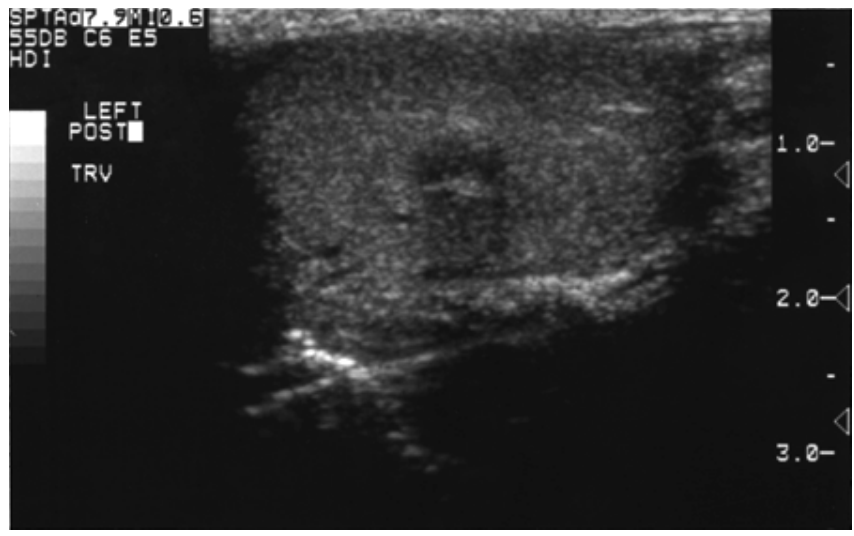
FIGURE 1 . Scrotal ultrasound identifies a heterogeneous 6 mm mass in the lower pole of the left testicle.